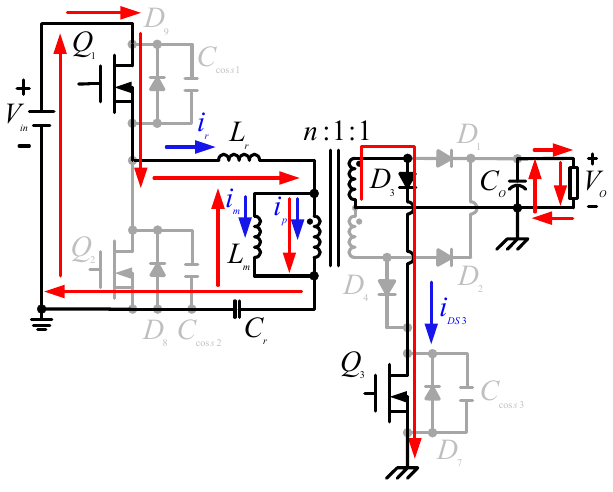
Figure 15. Working State 2 of novel LLC control